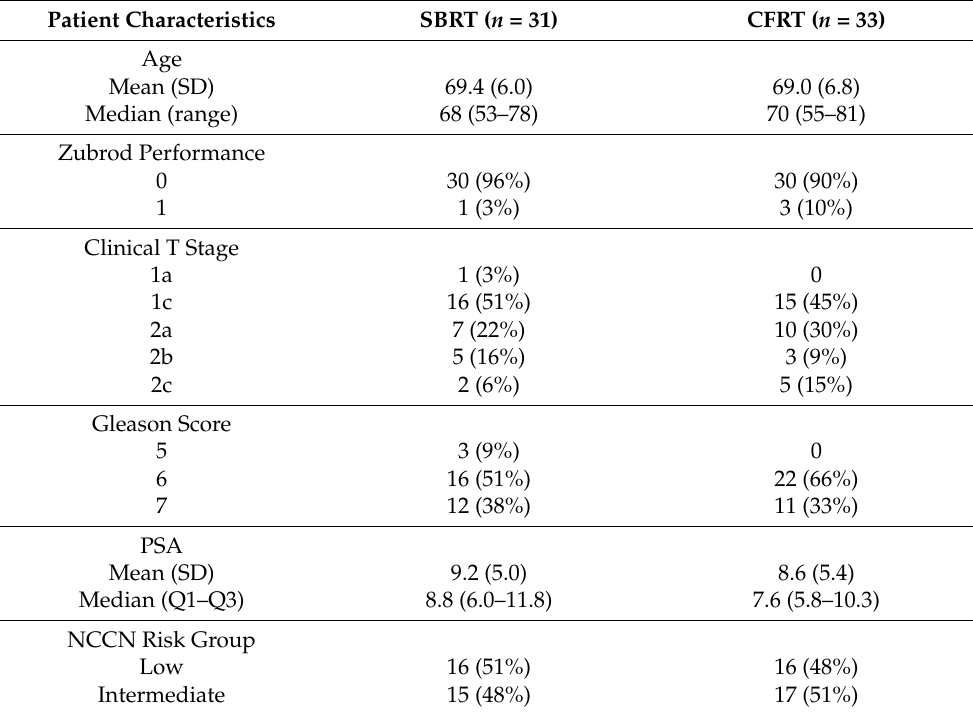
Table 1. Patient baseline